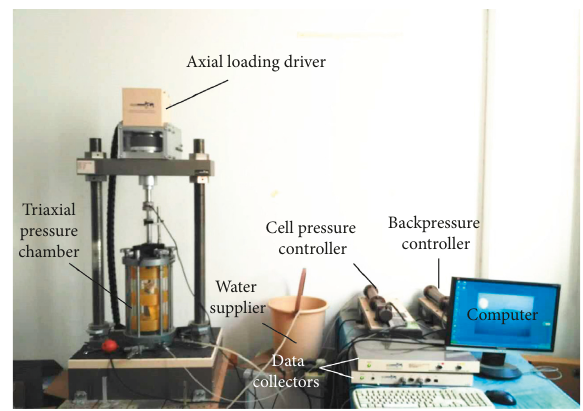
Figure 4: Cyclic triaxial testing